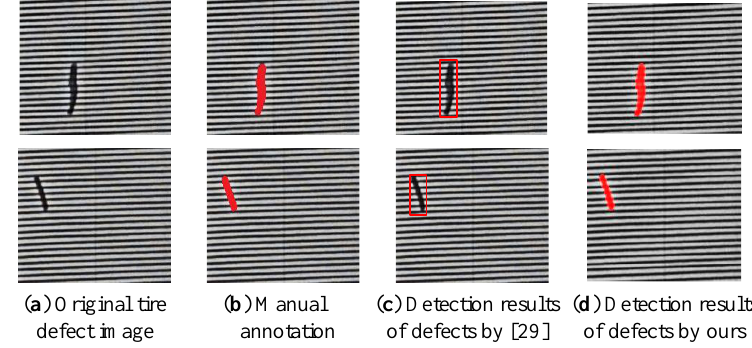
Figure 9. Experimental comparison of different detection